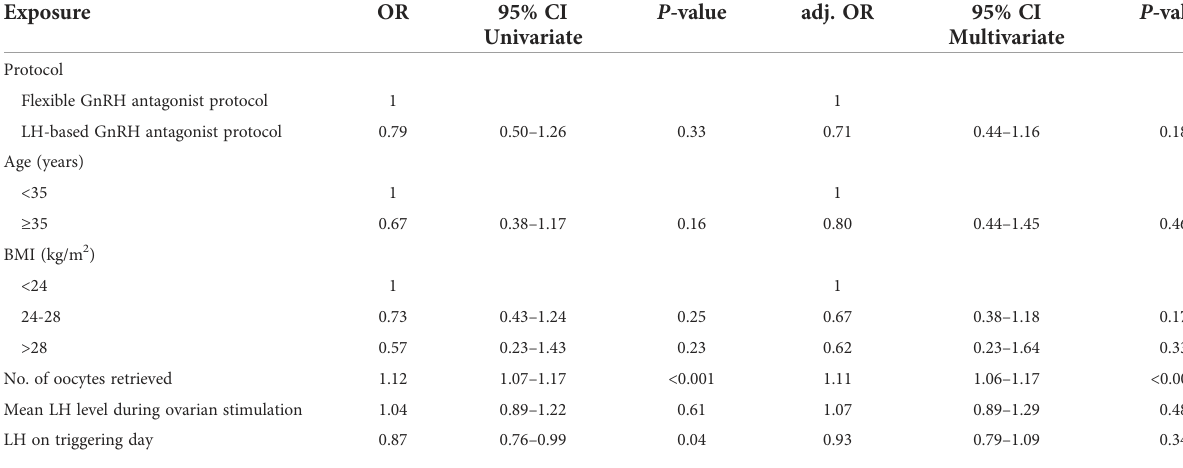
TABLE 4 Crude and adjusted OR for cumulative ongoing pregnancy rate of the per-protocol patients.